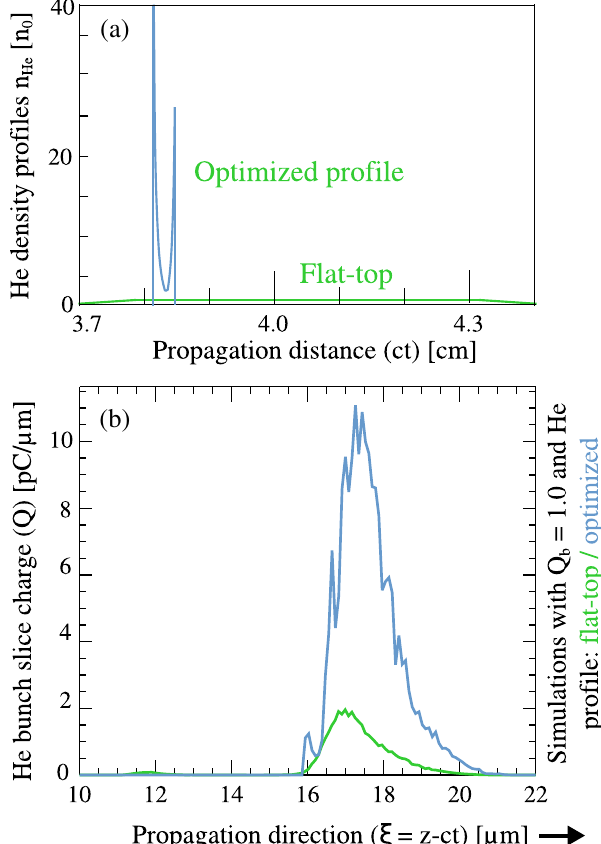
FIG. 7. (a) Illustration of the longitudinal profiles of the He impurity concentration for the simulation done using a flat-top and ramps profile (green) and for the simulation done with the optimized profile (blue). (b) Plot of the slice charge longitudinal density profile of the trailing beams injected via B-III near the back of the bubble at the end of the simulations, ct ¼ 6 cm, performed with driver charges of 1 nC and flat-top (green) and optimized profiles (blue). Longitudinal axis corresponds to the co-moving variable, ξ ¼ z − ct , and the propagation direction is from left to right side of the